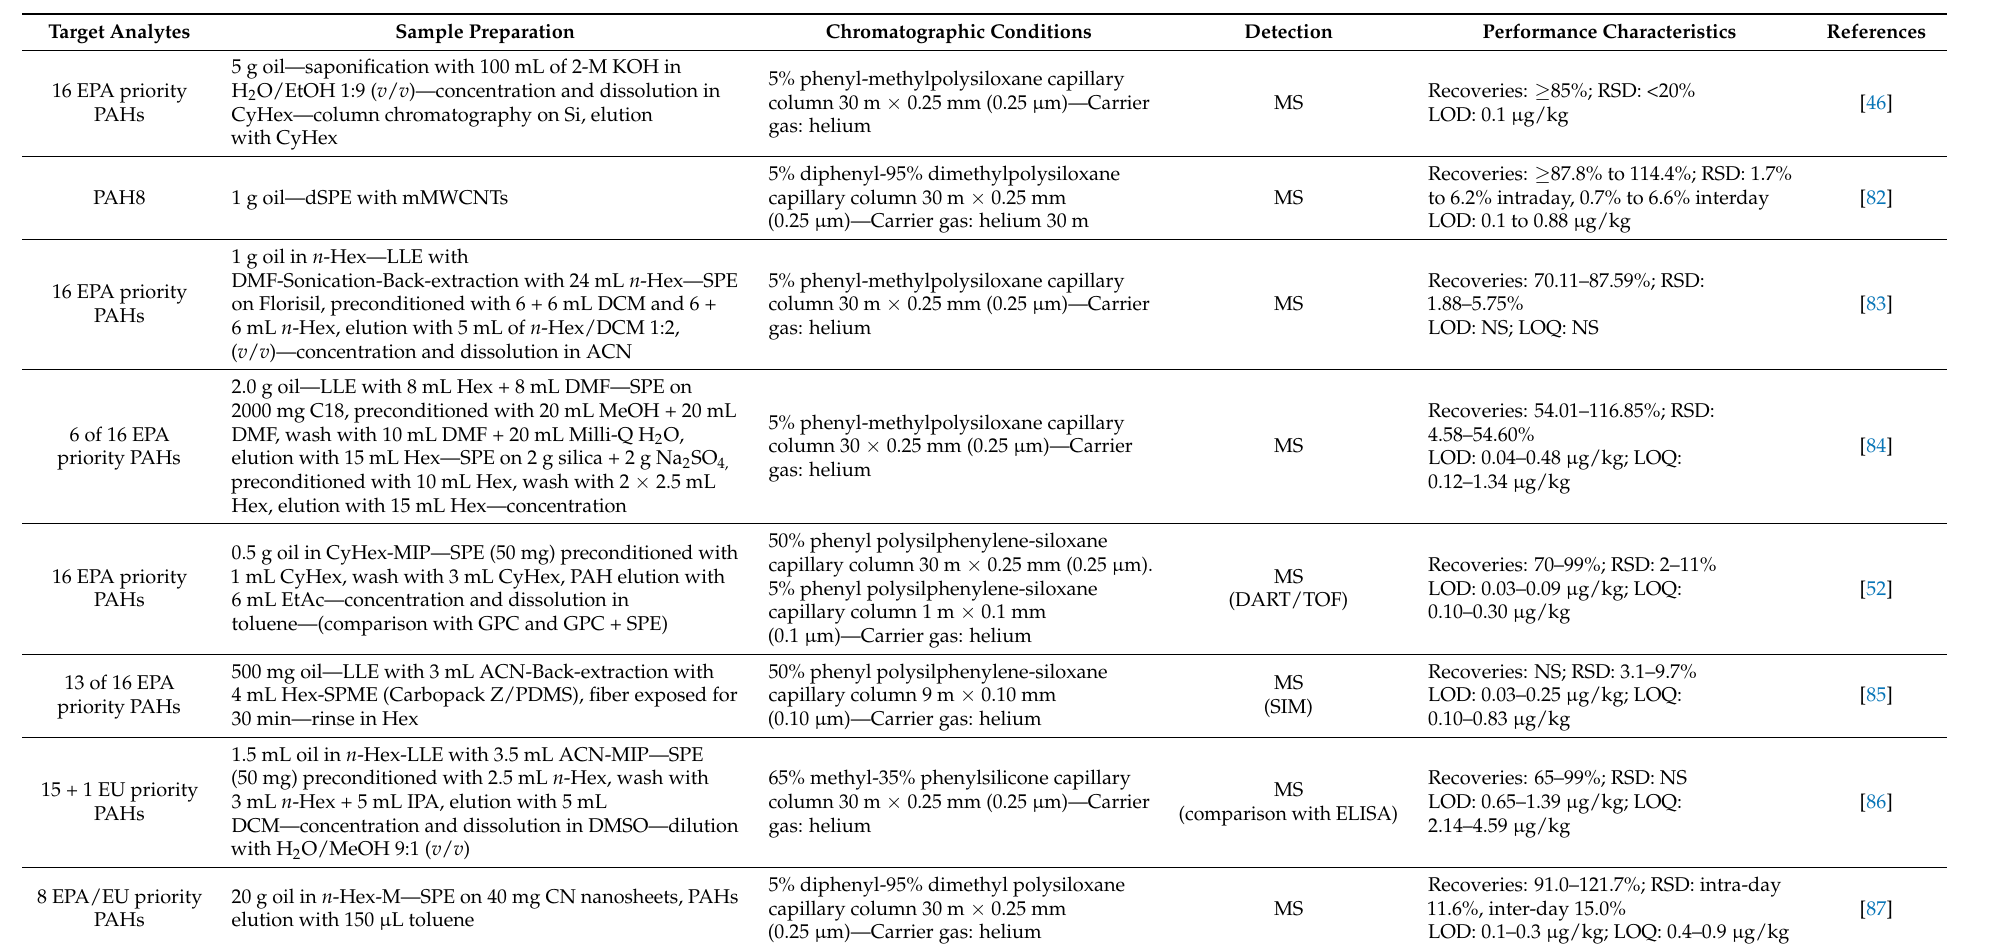
Table 4. Gas chromatography (GC) methods used for PAH determination in olive oils